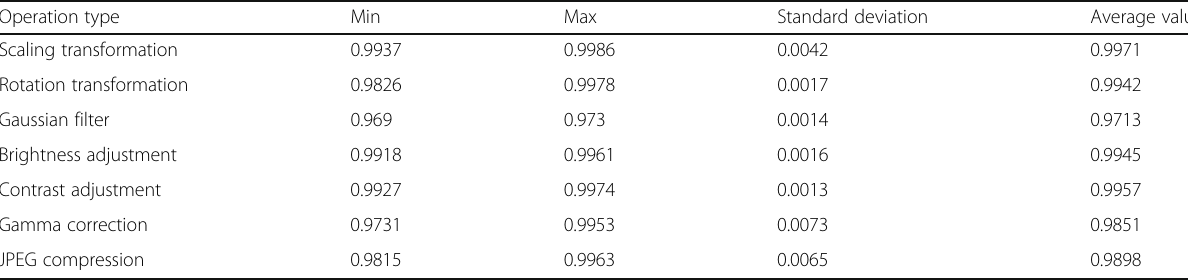
Table 1 Similarity measure statistics for various digital operations